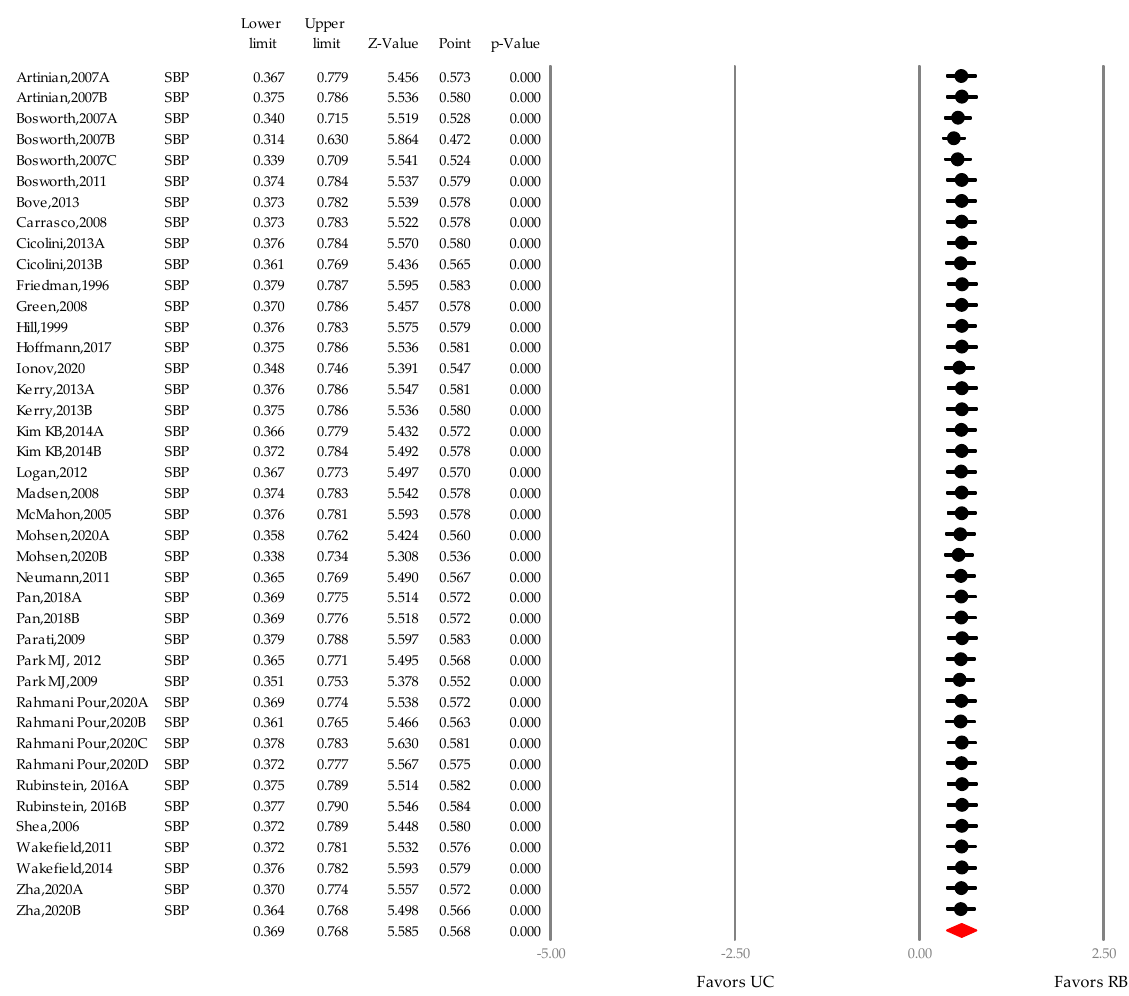
Funnel Plot of Standard Error by Std diff in means